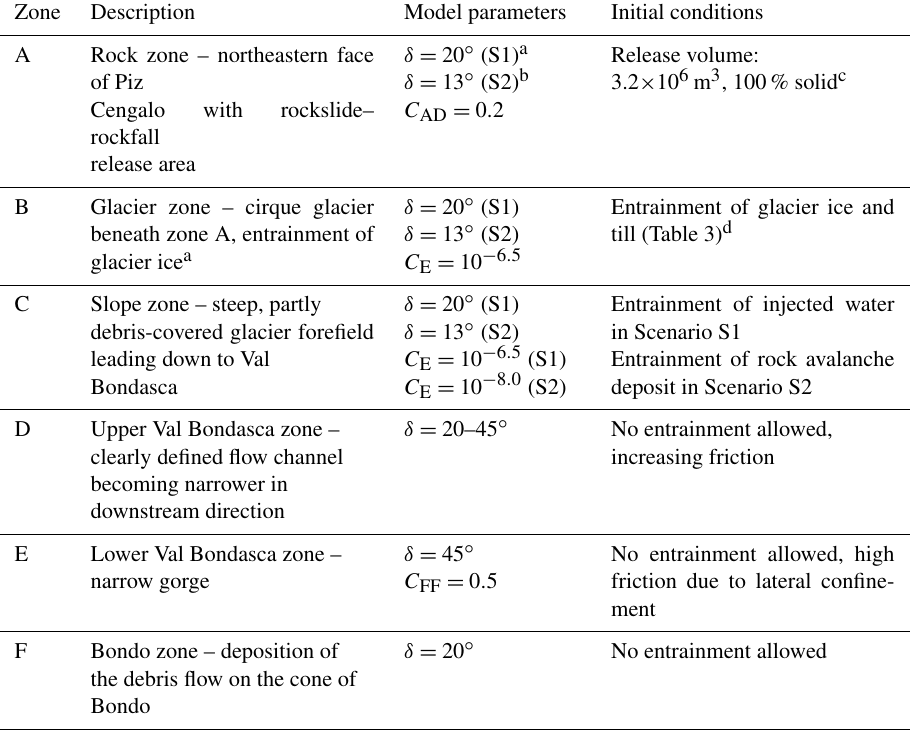
Table 1. Descriptions and optimized parameter values for each of the zones A–F (Figs. 4 and 7). The names of the model parameters are given in the text and in Table 2. The values provided in Table 2 are assigned to those parameters not shown. S1 and S2 refer to the corresponding scenarios.